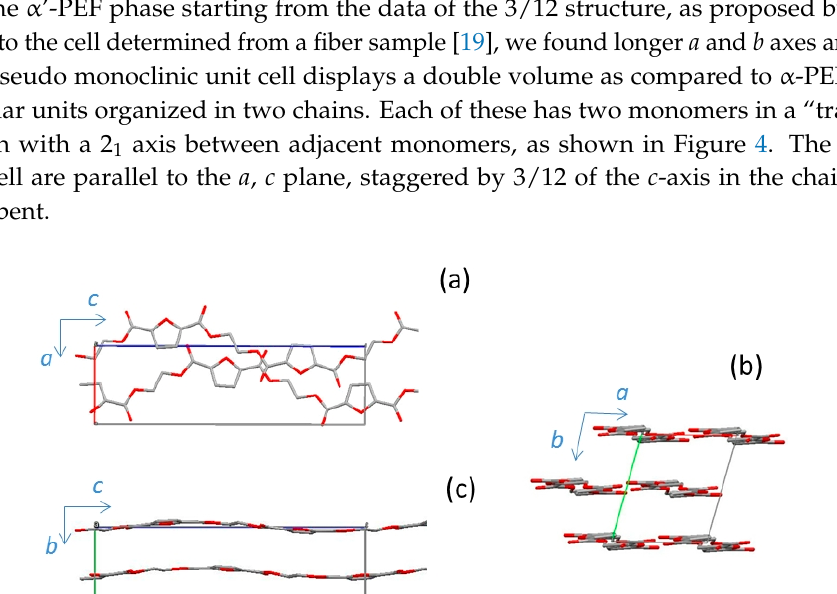
Figure 4. Views of the chain arrangement for the α ’-PEF structure: ( a ) projection down the b -axis; ( b ) along the c -axis; ( c ) projection down the a -axis. Oxygen atoms are in red.